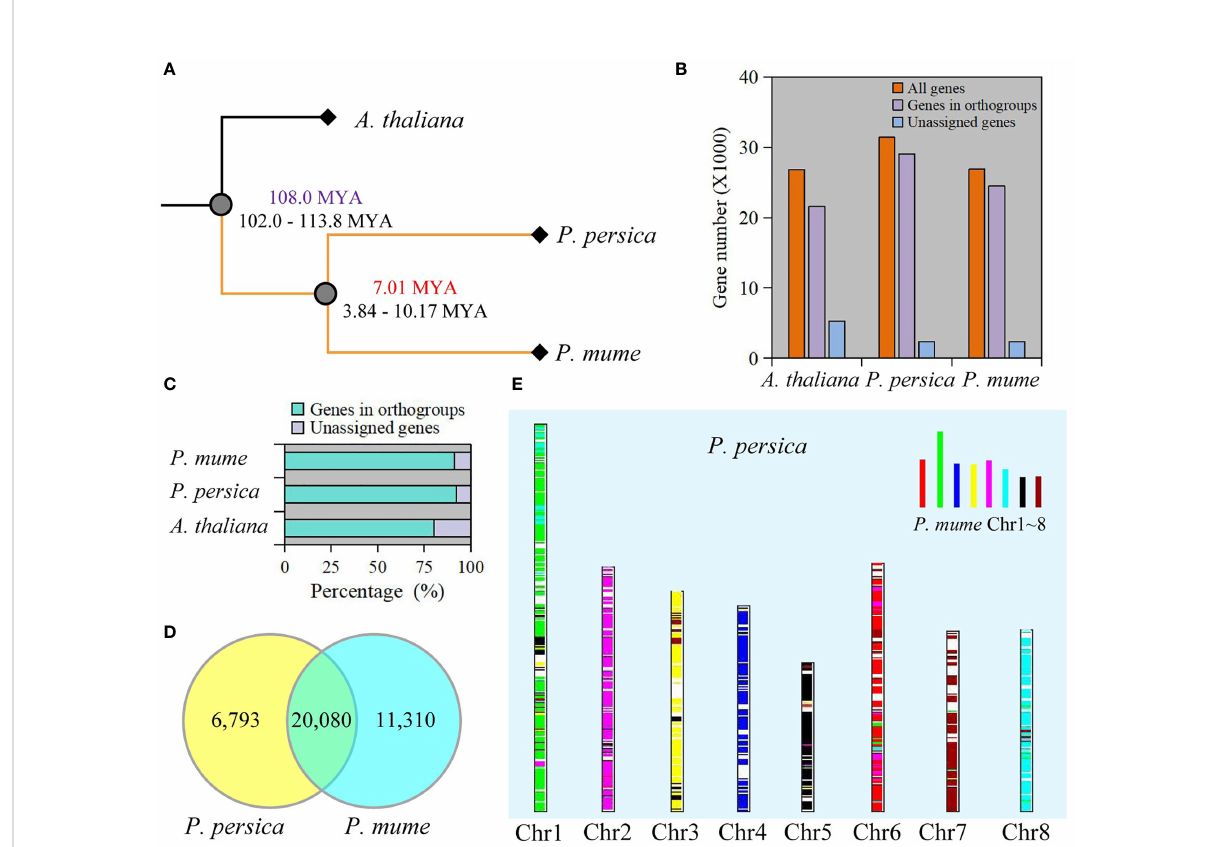
FIGURE 1 Comparative genomics between P. mume and P. persica. (A) The evolutionary relationships among A thaliana , P. mume , and P. persica . The evolutionary timescale of 102.0-113.8 Mya for the divergence between A thaliana and Prunus , and 3.84-10.17 Mya for the divergence between P. mume and P. persica . (B) The total number of genes in the genome, the number of genes in orthogroups, and the number of unassigned genes. (C) Percentage of genes in orthogroups and unassigned genes. (D) Collinearity genes comparison between P. mume and P. persica . (E) Comparison of the P. persica genome with the P. mume. Syntenic P. mume blocks are painted onto P. persica